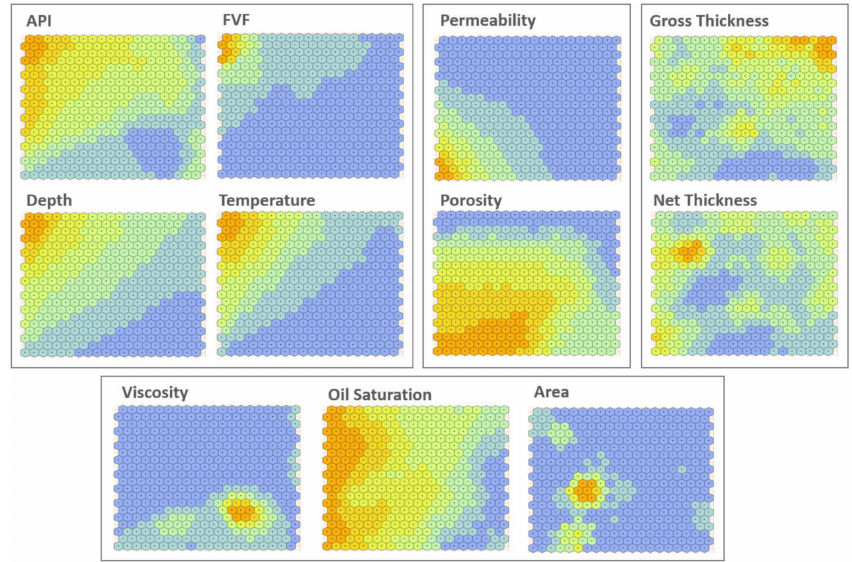
Figure 12. Heat maps indicate the individual input layers that generated the final SOM U-matrix (Figure 11). Input layers have been grouped based on data trends. In all maps, cold colours indicate small distances between data points and warm colours indicate large distances between data